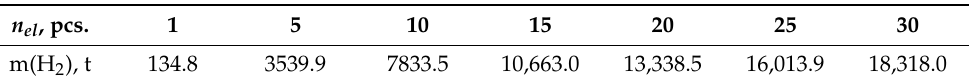
Figure 8. Capital cost of electrolysis depending on capacity of electrolytic unit and technology used. The mass of produced hydrogen relative to the number of electrolyzers. installed at the electrolysis plant is shown in Table 5. Table 5. Dependence of the mass of hydrogen produced by the electrolysis plant on the number of electrolyzers. installed at the plant.